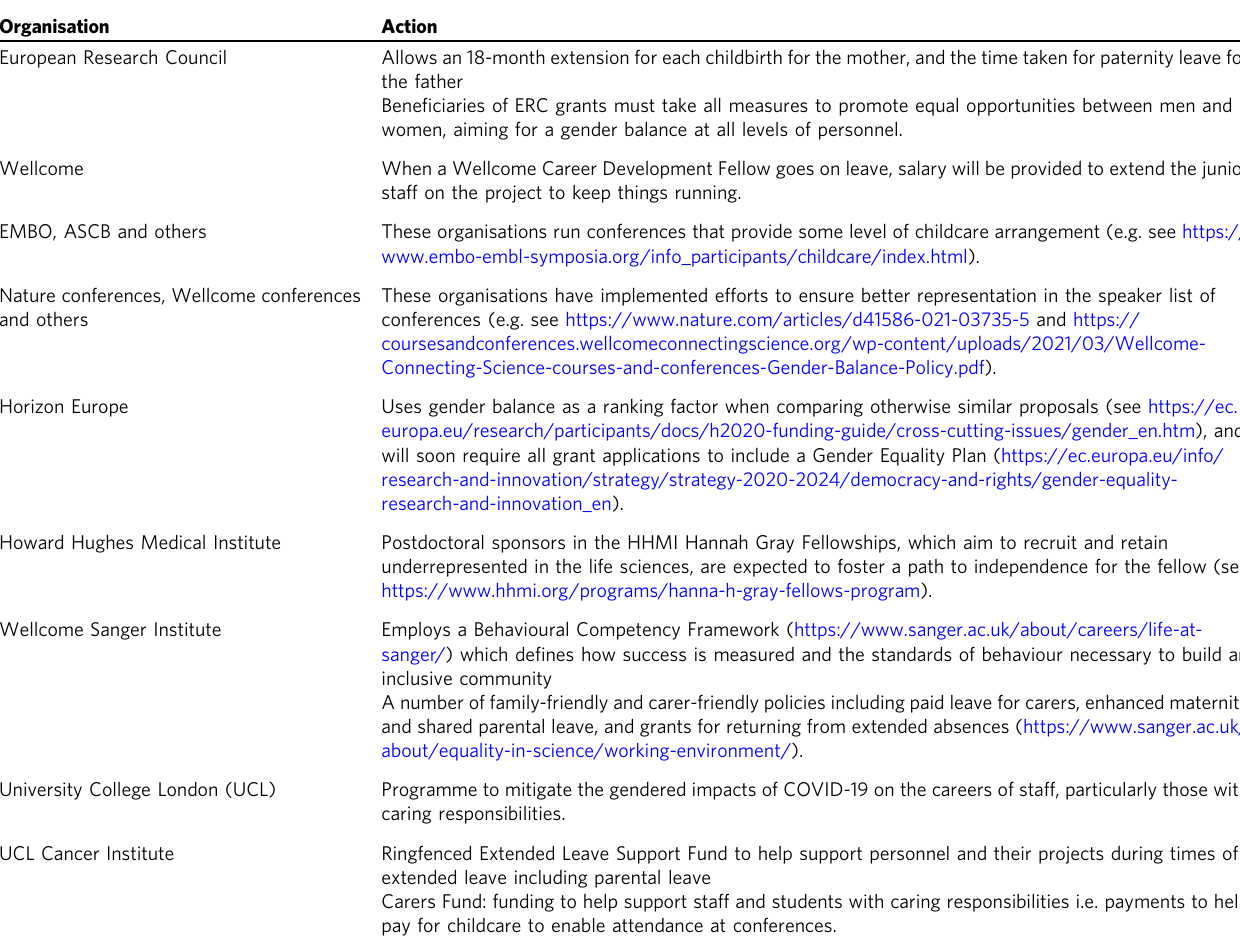
Table 2 Examples of positive actions from